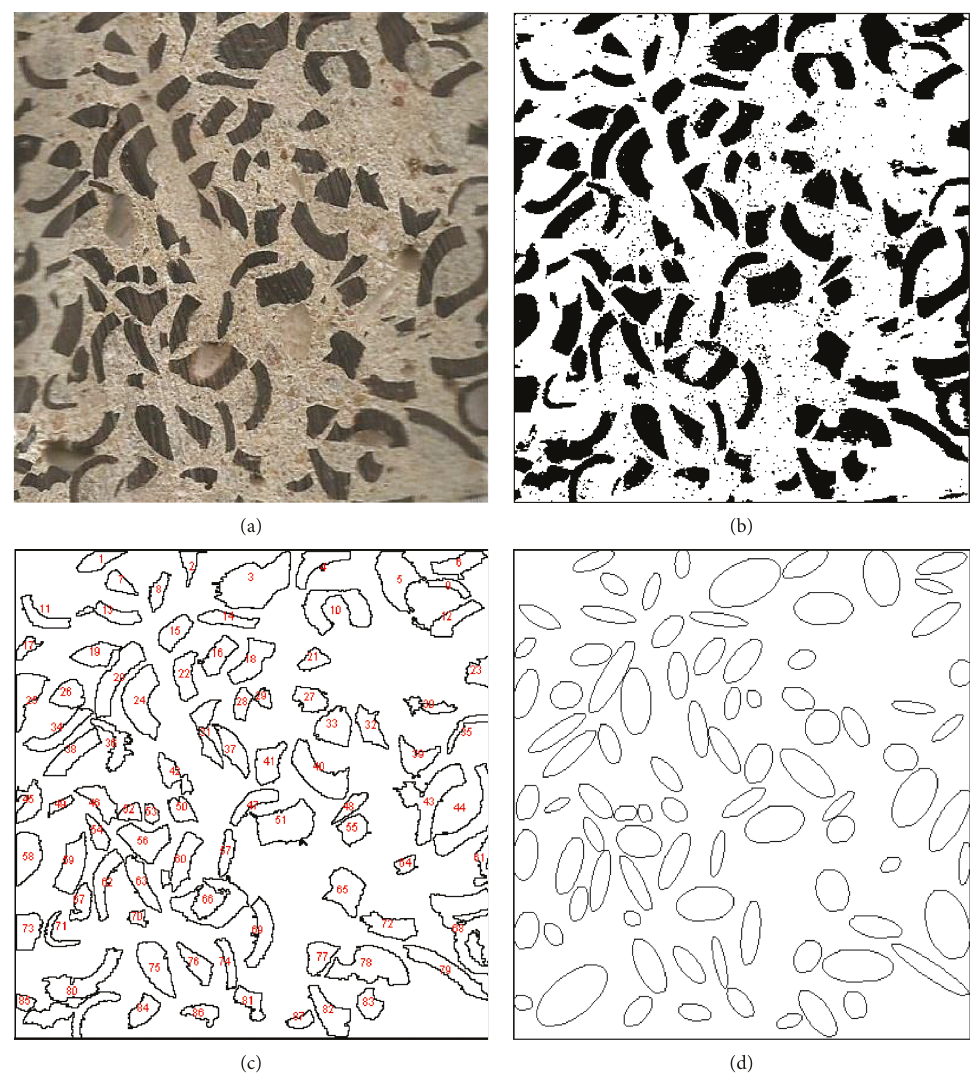
Figure 3: Procedure for image processing of RVE faces for OPKSC. (a) Original scanned image. (b) Binarised image obtained after thresholding, using by ImageJ ® . (c) Image depicting the labelled particles. (d) Image depicting the adjustment of ellipses on the particles (geometric